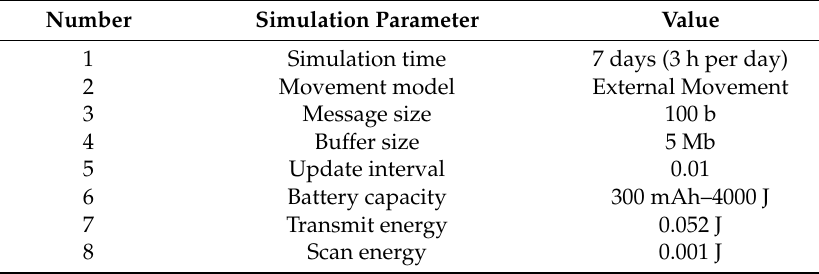
Table 1. Simulation parameters for both flying fox and pigeon